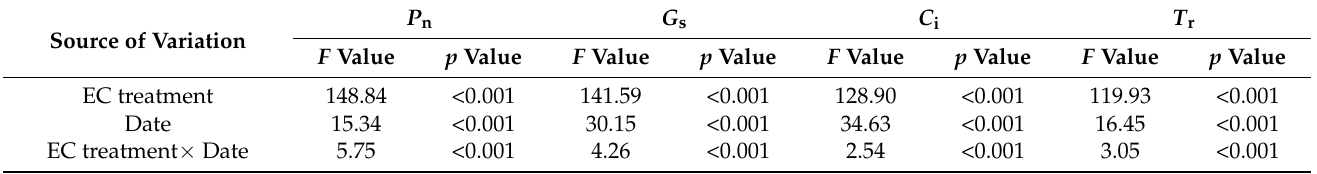
Table A1. Repeated measure ANOVA of the EC treatments, days of measurement, and their interac- tions on the net photosynthetic rate ( P n ), stomatal conductance ( G s ), intercellular CO 2 concentration ( C i ), and transpiration rate ( T r